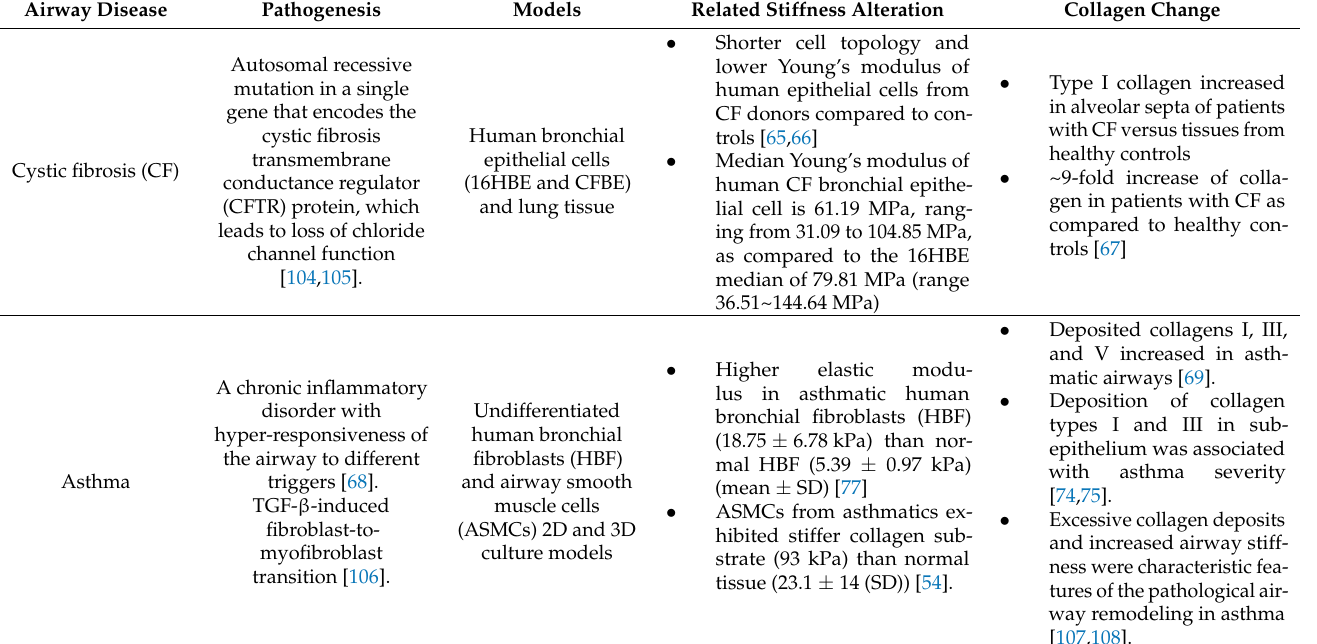
Table 3. Airway disease stiffness alteration and associated collagen